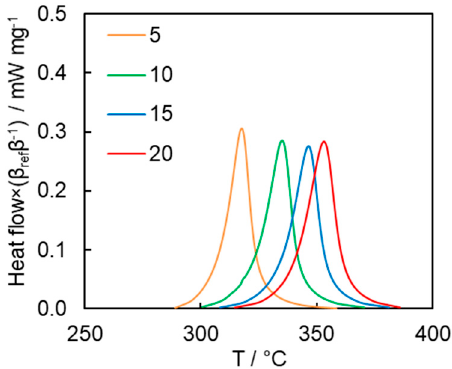
Figure 6. DSC curves for cyanate ester polymerization (numbers denote heating rates in °C min − 1 ). The heat flow values at different heating rates were normalized by a factor of 𝛽 𝑟𝑒𝑓 𝛽 − 1 , where 𝛽 is the heating rate and 𝛽 𝑟𝑒𝑓 is 1 °C min − 1 , to facilitate direct comparison of the DSC peaks.